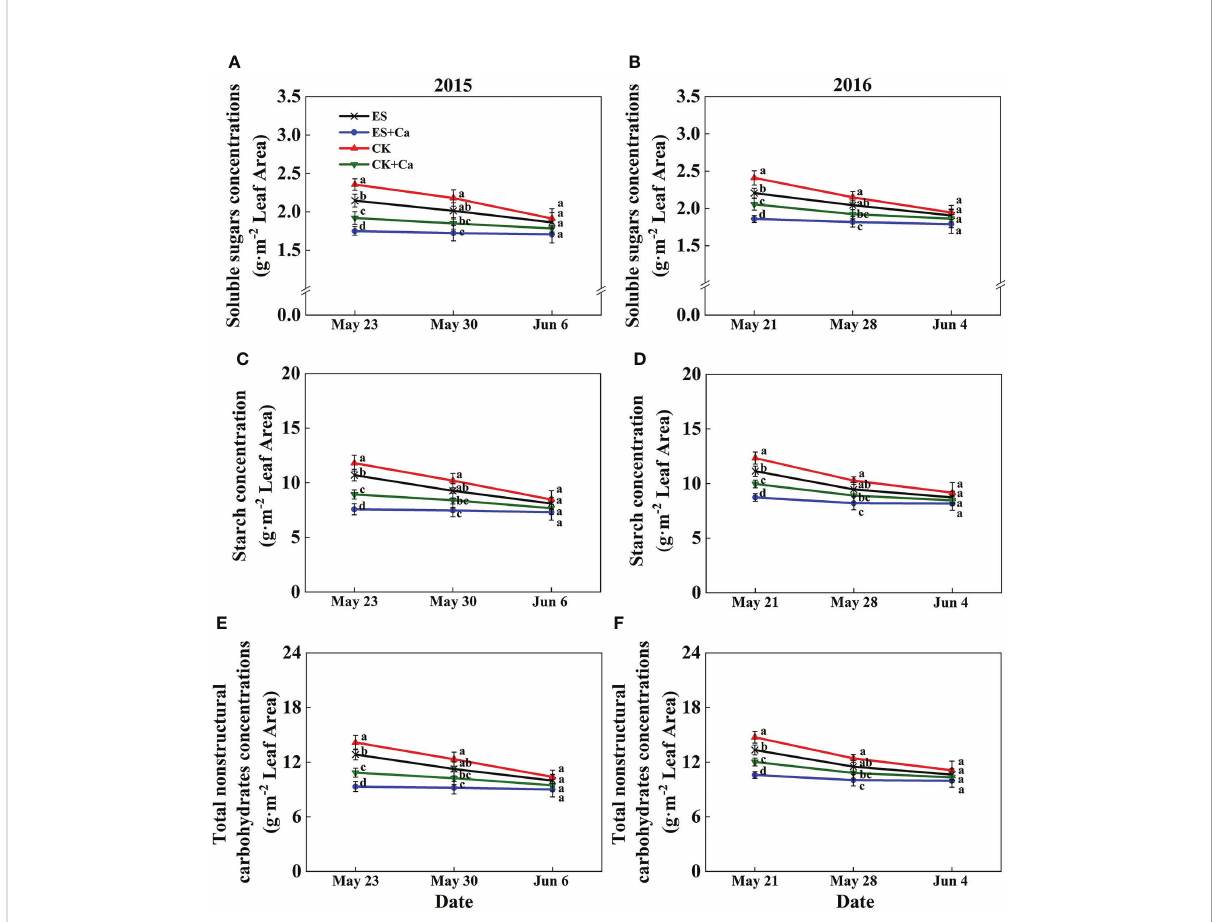
FIGURE 4 Effects of exogenous foliar calcium (Ca 2+ ) application on peanut leaf soluble sugars concentrations (A, B) , starch concentration (C, D) , and total nonstructural carbohydrates concentrations (E, F) under early and normal sowing scenarios. Values are means ± SD (n = 3). Different letters indicate signi fi cant differences according to Duncan ’ s multiple range tests ( p <